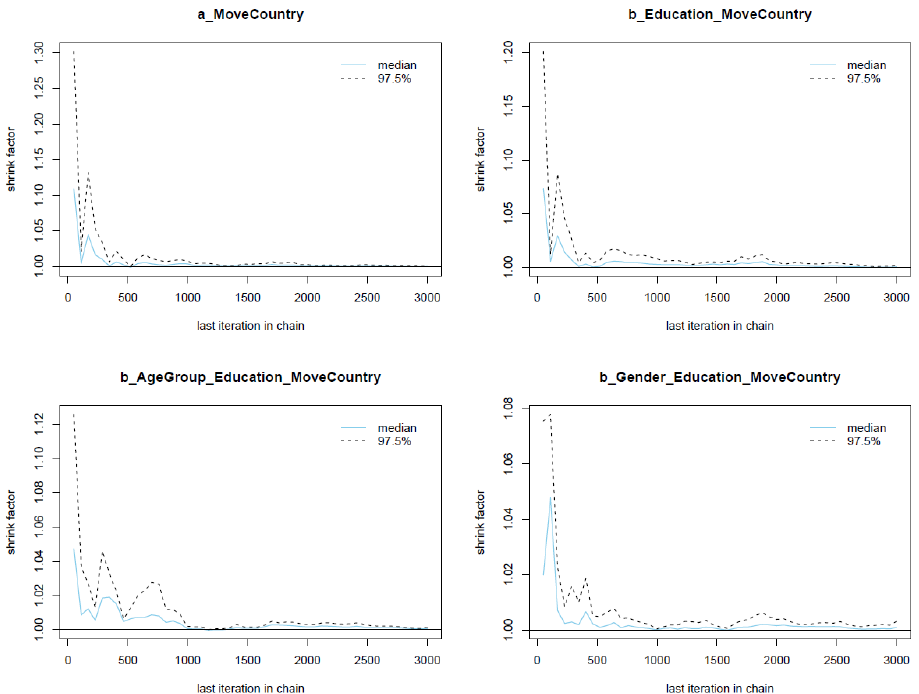
(cid:48) s posterior Figure A2. Gelman plots for Model 2′s posterior parameters. Figure A2. Gelman plots for Model 2 Figure A2. Gelman plots for Model 2′s posterior parameters.